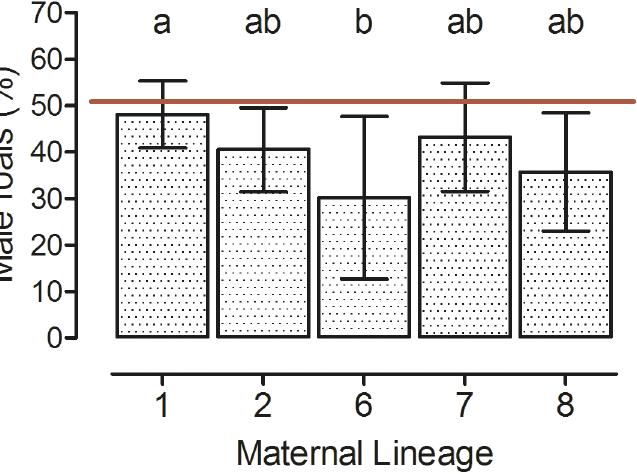
Fig 5. Percentage of male foals among the offspring of mares from different maternal lineages. Maternal lineage has an impact on the proportion of fillies and colts born (Model B, p = 0.027). Foals from maternal lineages: 1: n = 220, 2: n = 130, 6: n = 35, 7: n = 82, 8: n = 71 (LSM ± upper and lower limit of confidence; ab: groups with different superscript letters differ significantly, p = 0.0459; red horizontal line indicates expected 50% ratio of male foals